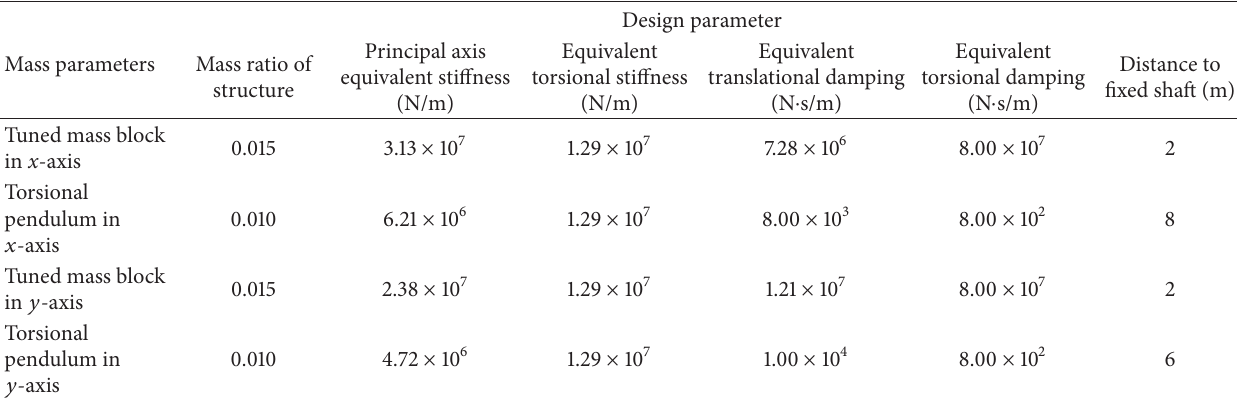
Table 1: Design parameter of